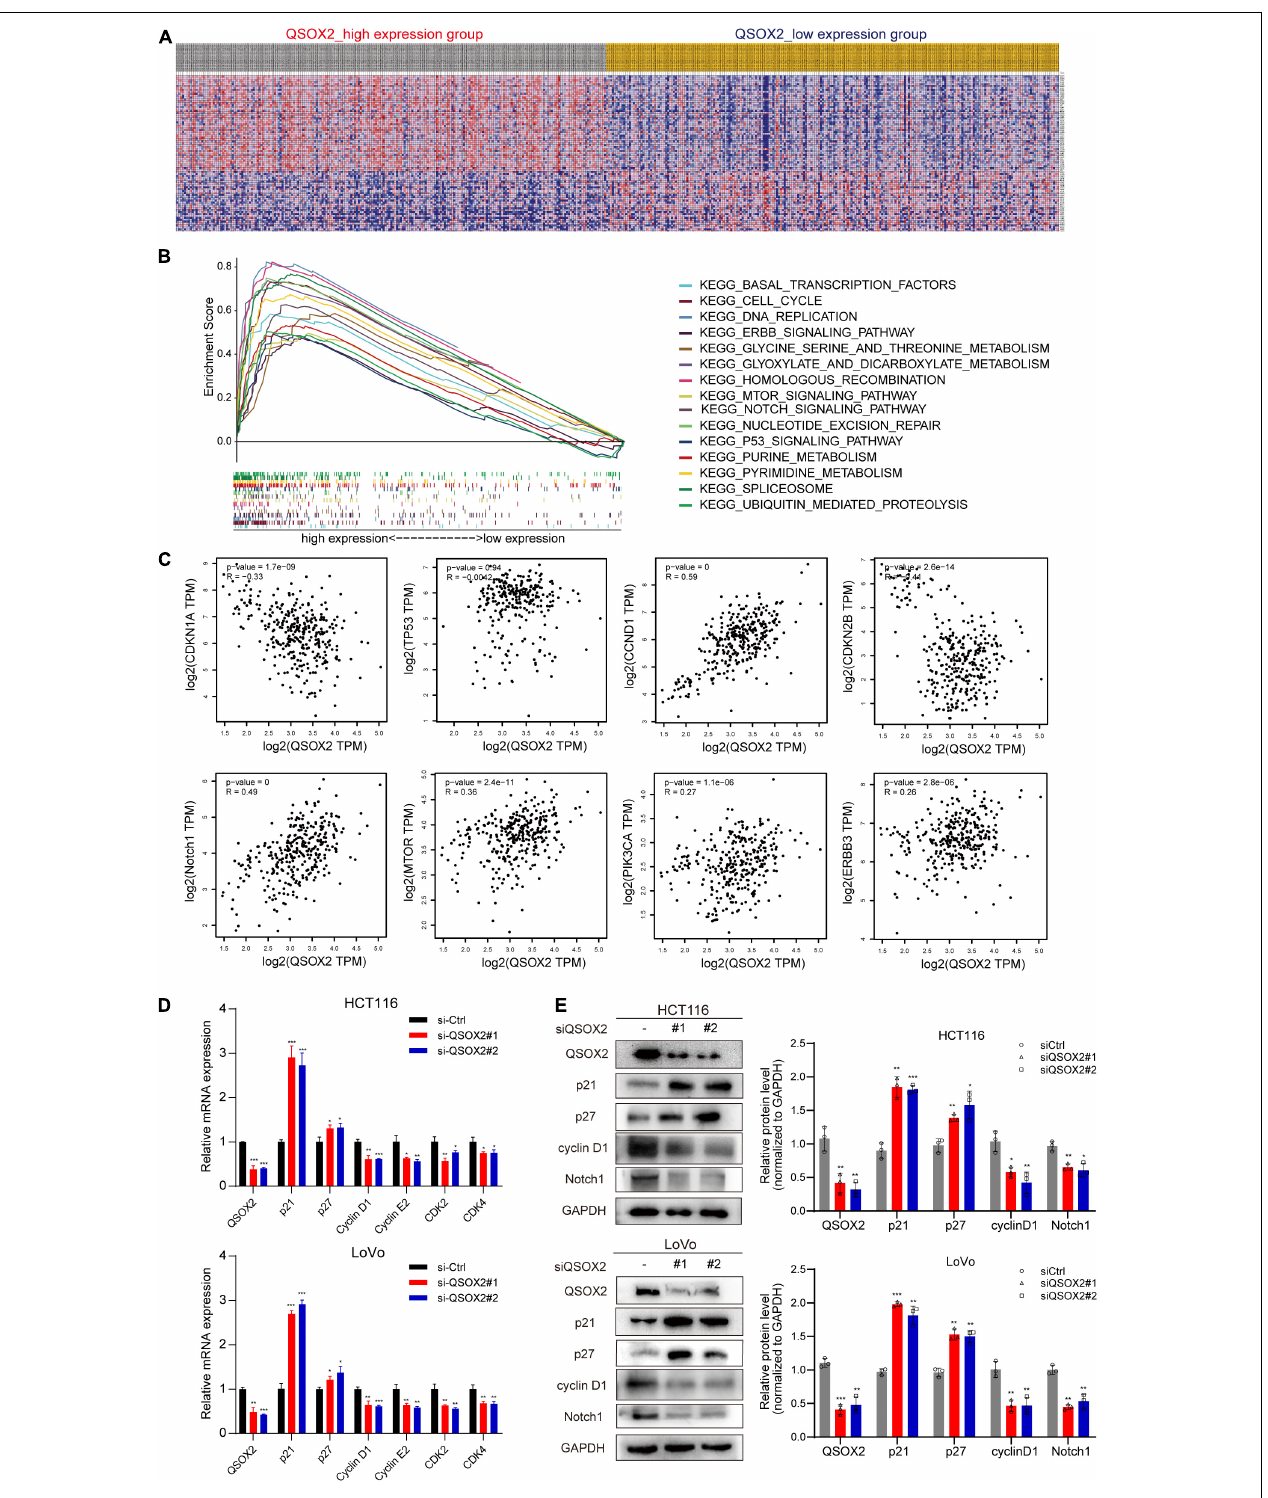
FIGURE 5 | Mechanistic investigation into how QSOX2 promotes CRC progression. (A) The heat map generated based on genes enriched in QSOX2 high and low in TCGA database. (B) Enrichment plots from Gene Set Enrichment Analysis (GSEA) including enrichment score and gene sets. (C) Correlation between QSOX2 and signaling pathway-related genes, including p21, p27, cyclin D1, p53, Notch1, mTOR, PIK3CA, and ERBB3. (D) The e mRNA expression of cell cycle signaling pathway genes in CRC with knockdown of QSOX2 were determined by qRT-PCR. (E) The expression of QSOX2 and signaling pathway-related genes were detected by Western blotting, and GAPDH was used as a reference control. * p < 0.05; ** p < 0.01; *** p < 0.001.